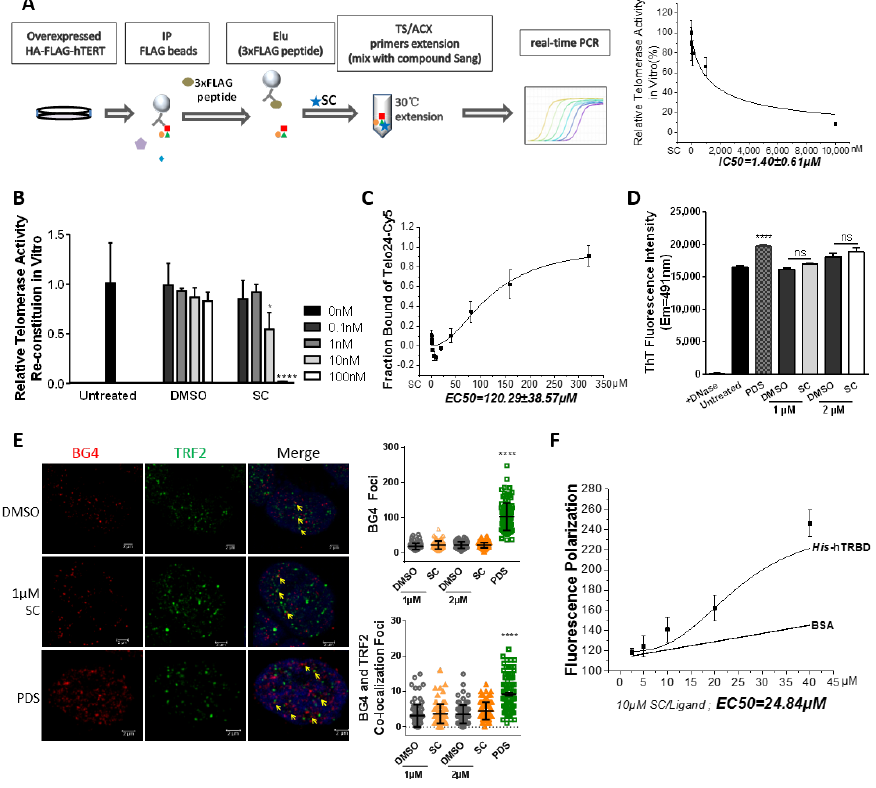
Figure 5. SC directly suppressed telomeric repeat extension in vitro without inducing a G-quadruplex motif. ( A ) Schematic representation of immunoprecipitation-based TRAP experiment. FLAG-hTERT-overexpressing HEK293T cells were subjected to immunoprecipitation. The elutes mixed with SC were used to perform the TRAP assay in vitro. The inhibition of natural telomerase activity by SC was presented in a dose-dependent manner, and the fitting curve showed that its IC50 to natural telomerase in vitro was 1.4 µ M. ( B ) Purified GST-opTERT was incubated with in vitro-transcribed hTERC for 30 min, then mixed with SC to perform the TRAP assay. SC directly suppressed the activity of reconstituted telomerase at the nanomole level in vitro. ( C ) MST analysis of the interaction of the telomeric G-quadruplex with SC. The EC50 was 120 µ M. ( D ) Detection of 2 µ M Thioflavin T (ThT) fluorescence intensity at 491 nm for the whole genomic DNA in a K + Tris-HCl buffer. Pyridostatin (PDS) was the positive compound used to induce G-quadruplex structure. ( E ) Representative immunofluorescence images of the G-quadruplex (recognized by BG4 antibody, red) and TRF2 (green) foci in HTC75 cells treated with SC or DMSO for 48 h. Quantification of the number of G-quadruplex foci (recognized by BG4 antibody) per nucleus in compound-treated HTC75 cells (right upper) and quantification of the number of colocalized G-quadruplex foci (recognized by BG4 antibody) and TRF2 in the nucleus (right bottom). In total, 100 nuclei were counted and statistically analyzed. ( F ) A fluorescence polarization binding assay with His-tagged hTRBD and SC was performed, and the EC50 was 24.84 µ M; the BSA protein served as a negative control. All the analyses were performed on triplicate samples (* p < 0.05, **** p < 0.0001, ns means no